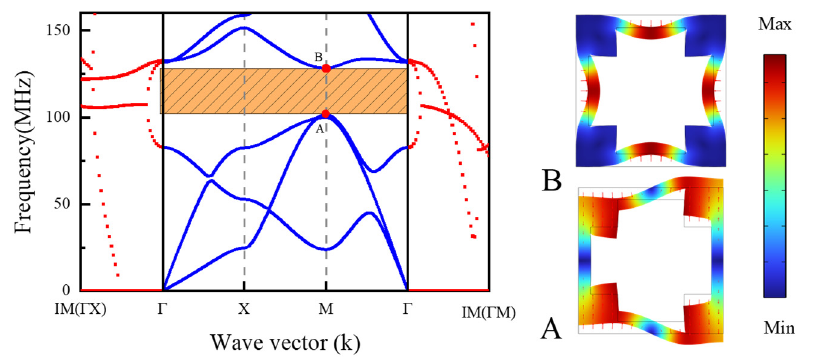
Figure 3. Cross-like holey PnC structure. The left side is the complex energy band curve of the cross-like holey PnC structure, the blue solid line represents the real wave vector energy band curve, and the red dotted line represents the imaginary wave vector attenuation curve. On the right is the special point mode shape of the band gap boundary.